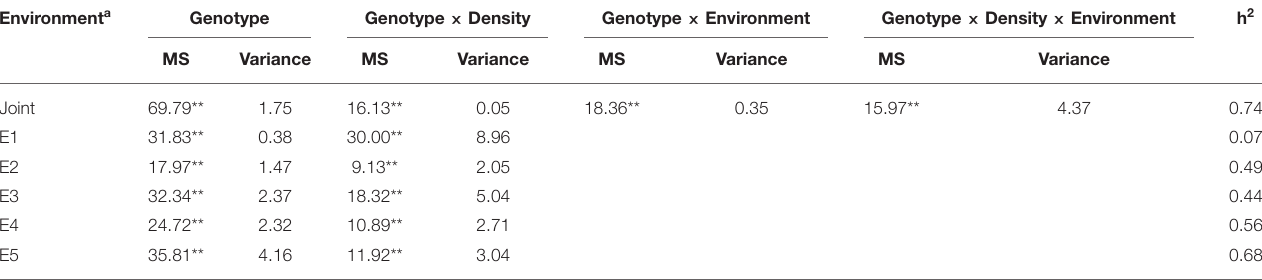
TABLE 2 | Variance and heritability of nod number in main stem of four-way recombinant inbred lines. Environment